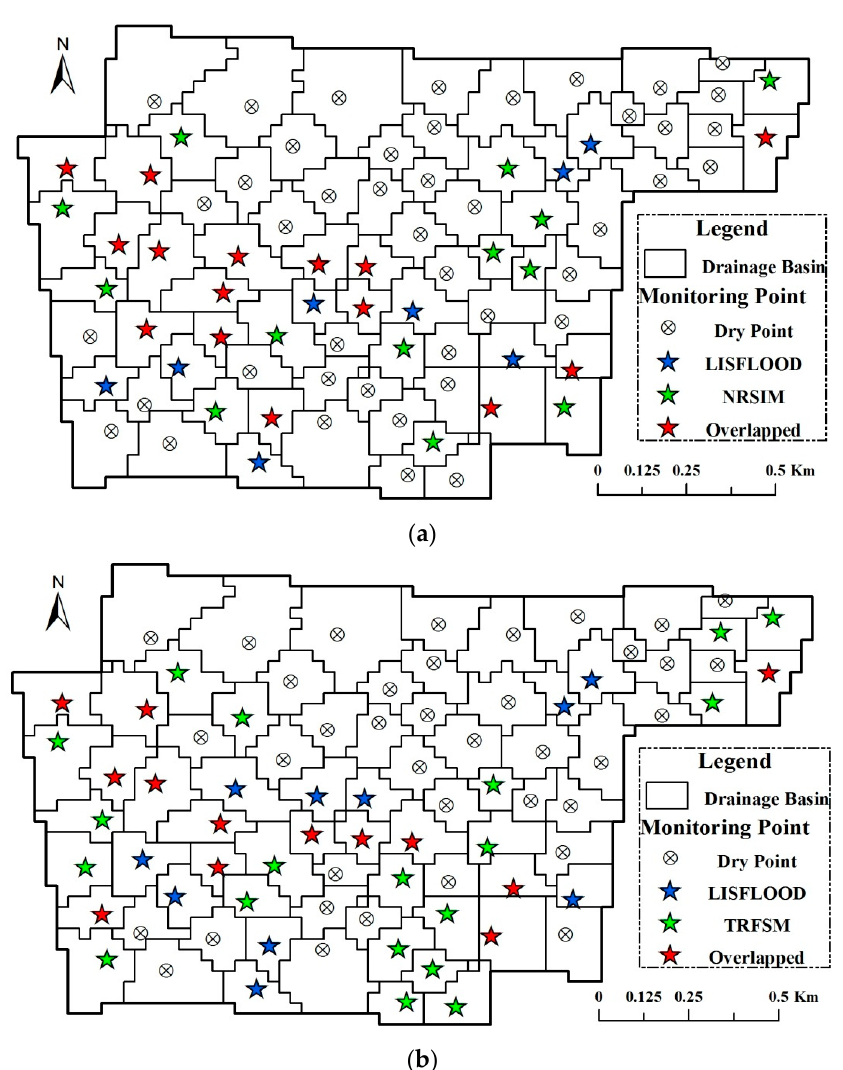
Figure 13. Comparison of inundation extent between LISFLOOD and: NRSIM ( a ); and TRFSM ( b ) using a 90 ‐ m resolution DEM.